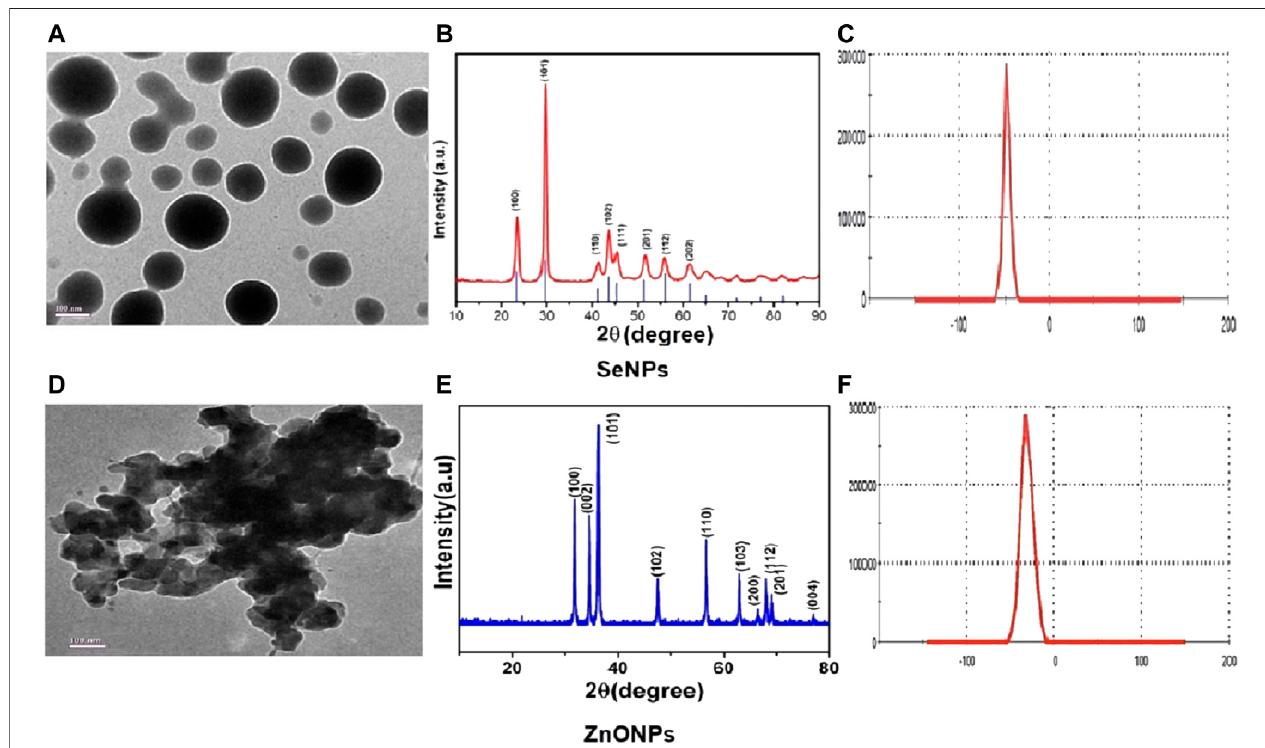
FIGURE 1 | Physicochemical characterization showing the representative images of TEM (A) , XRD (E) , and zeta potential (B) for assessing the stability in solution for SeNPs (C) and ZnONPs (D) .